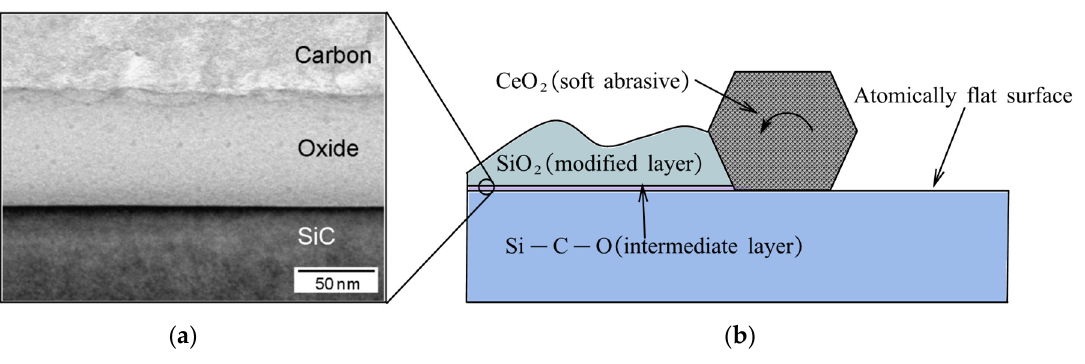
Figure 10. The removal mechanism in plasma-assisted polishing: ( a ) Cross sectional transmission electron microscopy images of H 2 O containing plasma irradiated 4H-SiC surface. Reproduced with permission from [97]; ( b ) The removal process in PAP at microscopic.